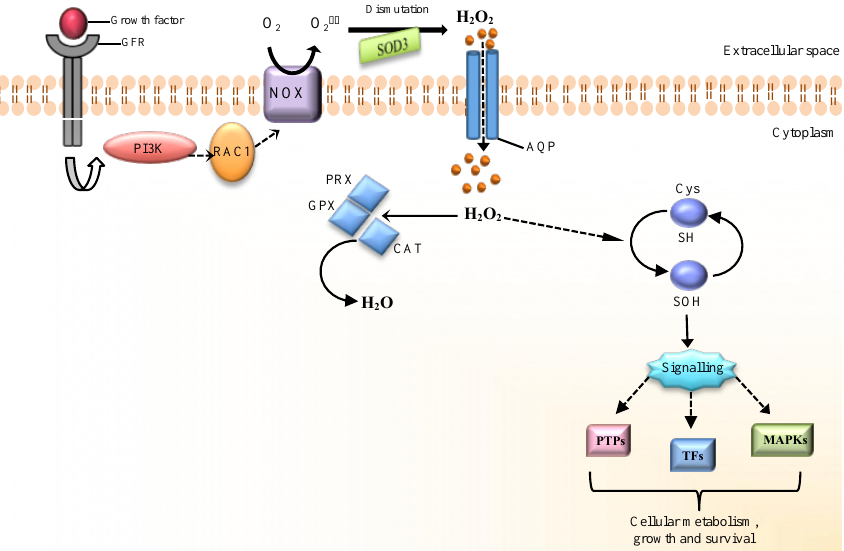
Figure 1. H 2 O 2 signaling in mammalian cells. The binding of growth factors (e.g., EGF or PDGF) to their receptors triggers several downstream events. NADPH oxidase (NOX) is a membrane-bound